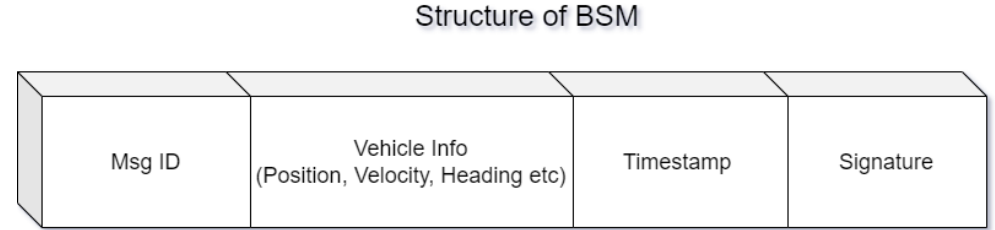
Figure 2. RSU detecting an attacker vehicle and alerting others.